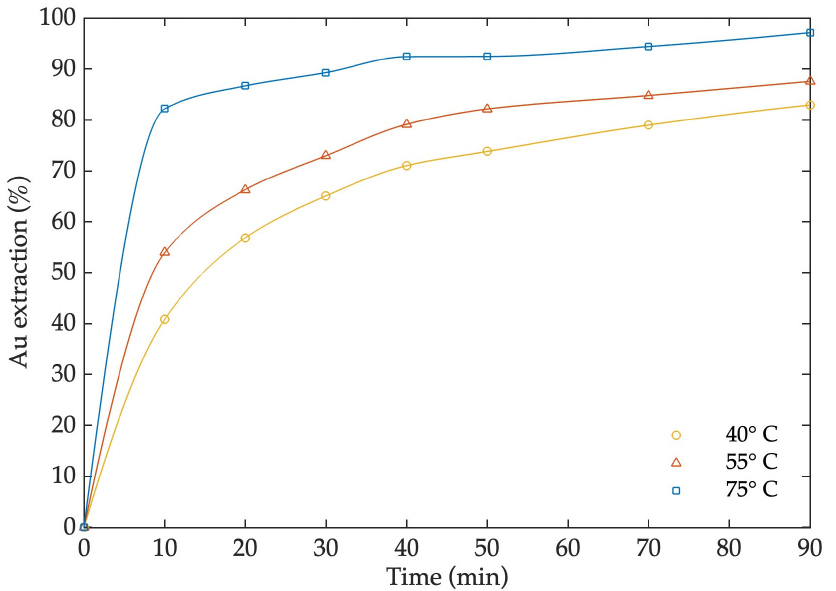
Figure 5. Au extraction (%) from simultaneous pressure leaching and oxidation at a pressure of 0.5 MPa and 6 g/L cyanide concentration.